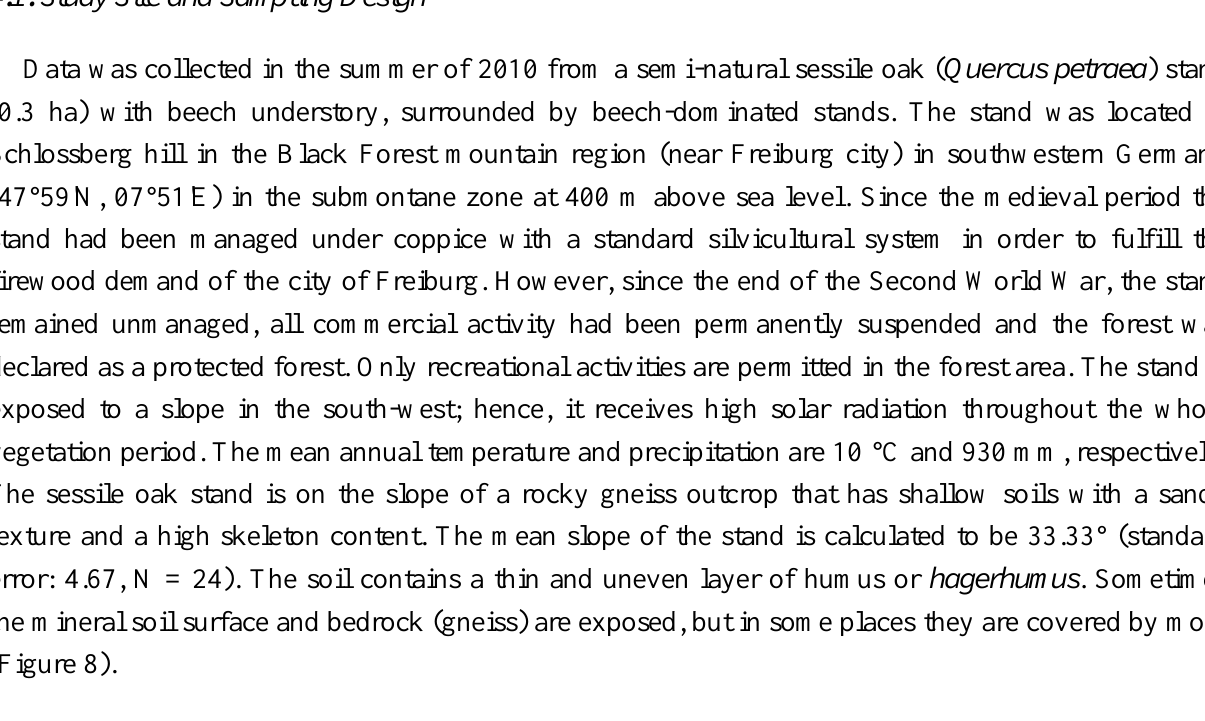
Figure 8. Study site at Schlossberg ( a ), partially dead standing young understorey beech plant ( b ), sampled beech plant with a dead branch on the left and a living branch on the right side ( c ), shallow soil profile at the study plot ( d